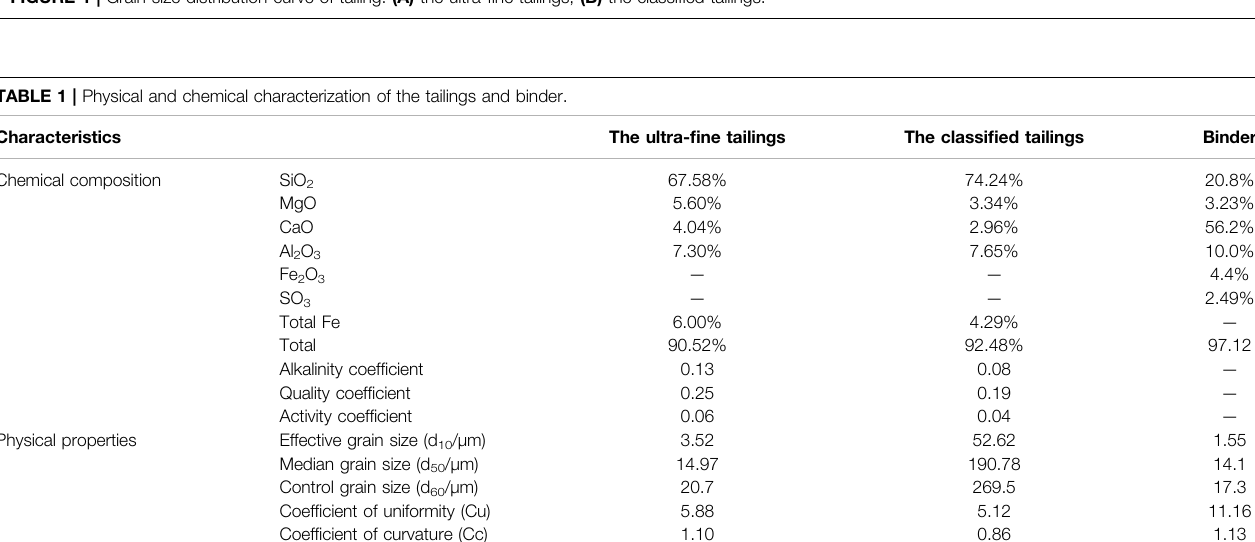
FIGURE 1 | Grain size distribution curve of tailing: (A) the ultra- fi ne tailings; (B) the classi fi ed tailings.